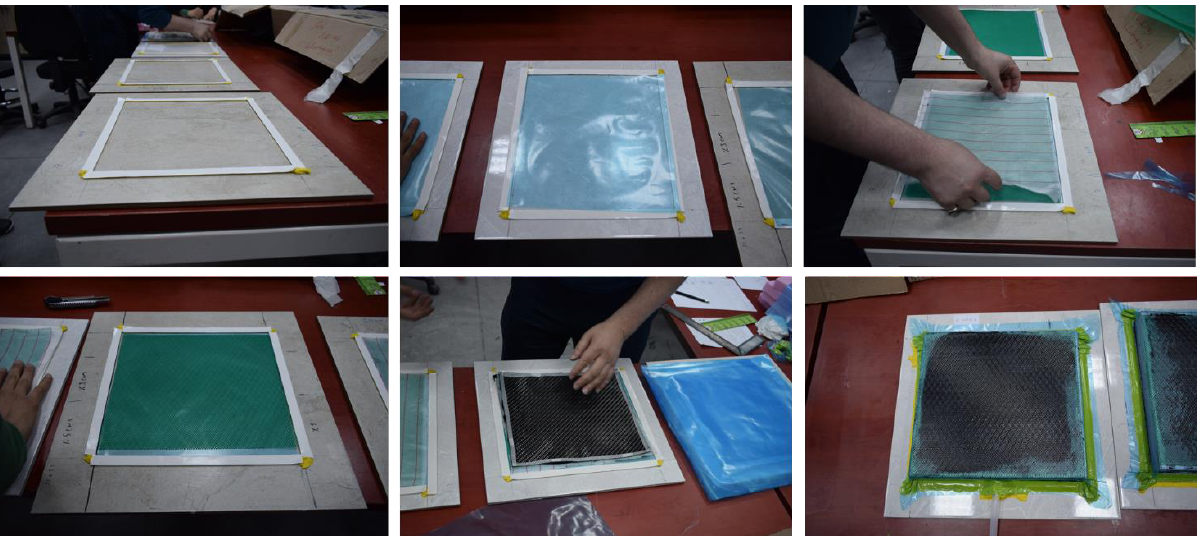
Figure 2. Manufacture of CNTRC composite material.